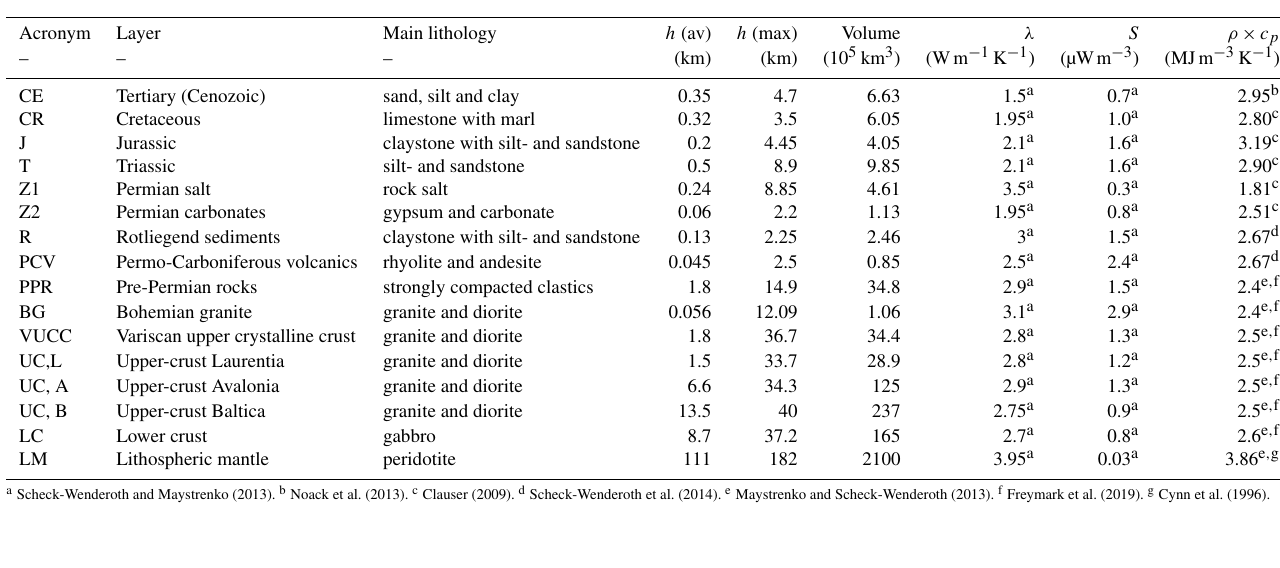
Table A1. Geometrical and rock physical properties of the different units integrated in the 3-D structural model. Symbols listed are as follows: h (av) is average unit thickness, h (max) is maximum unit thickness, λ is thermal conductivity, S is heat production rate, ρ is density, and c p is rock heat capacity. The unit volume has been computed based on the average thickness of each unit.